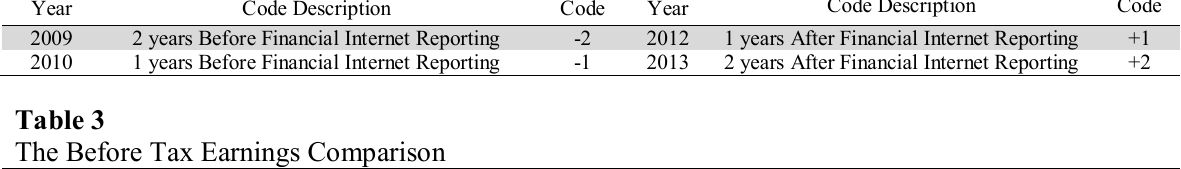
The Before Tax Earnings Comparison